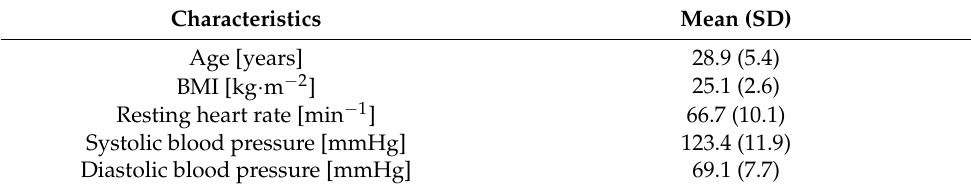
Table 1. Baseline characteristics of the study population (healthy male volunteers).